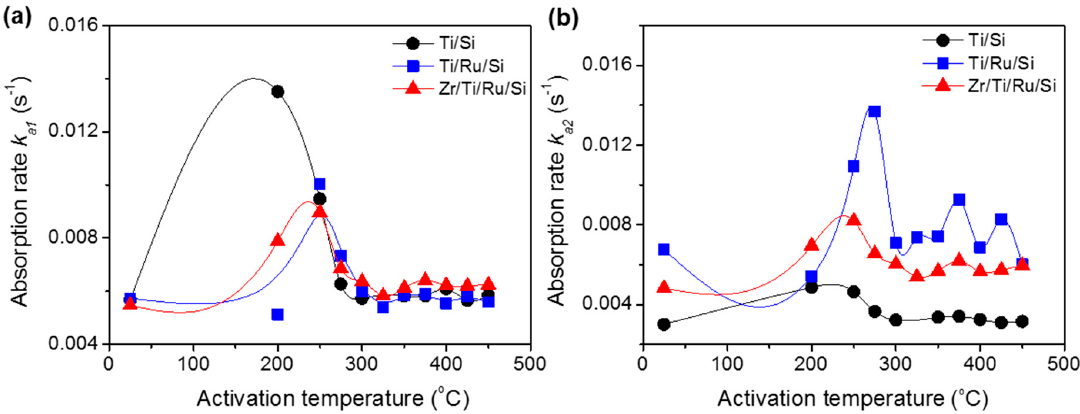
Figure 8. Nitrogen sorption rate constants, k a , at different activation temperatures. ( a ) Reaction rate constant, k a 1 , in the rapid sorption stage; ( b ) reaction rate constant, k a2 , in the stable sorption stage.